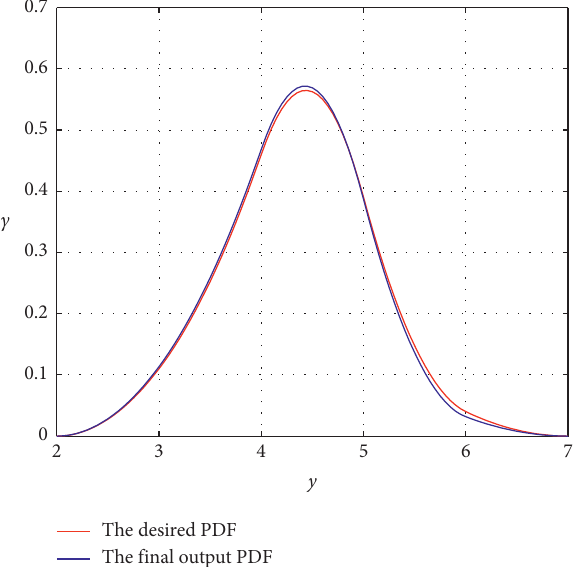
Figure 14: The expected output PDF and the final output PDF with the first-order sliding mode FTTC strategy.